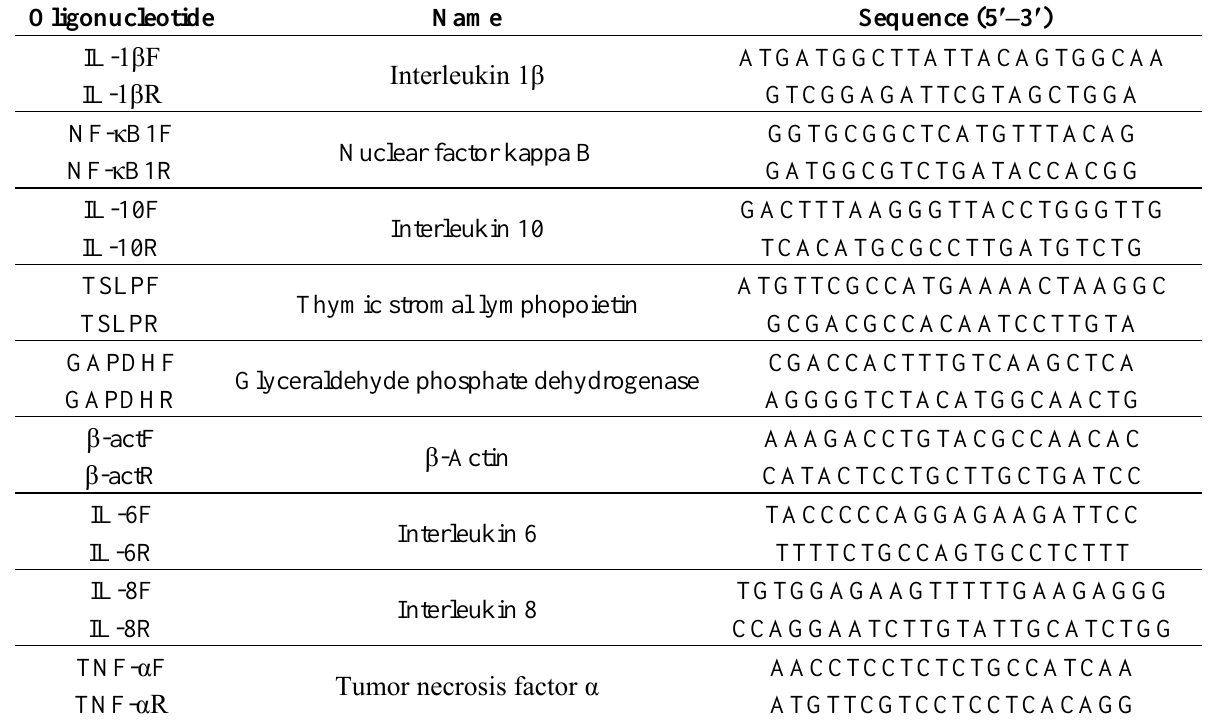
Table 2. Oligonucleotides used in Q-PCR